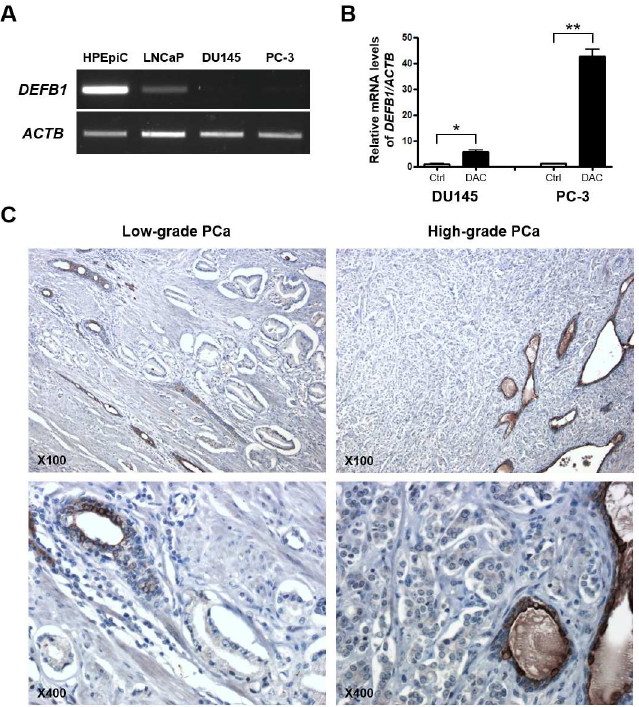
Fig 1. Downregulation of the DEFB1 gene in prostate cancer (PCa) cell lines and tissues. (A) DEFB1 mRNA expressionin prostate epithelial cell lines was assessedby performingRT-PCR. The human ACTB gene (encoding β -actin) was amplifiedas an endogenouscontrol. (B) Quantitative PCR was performed to evaluatethe restorationof DEFB1 mRNA expressionin DU145 and PC-3 cells after treatment with DNA demethylating agent 2 0 -deoxy-5-azacytidine(DAC). * P < 0.05 and ** P < 0.01. (C) Immunohistochemical stainingof DEFB1 in prostate cancer tissue samples. PCa, prostate cancer; NT, non-tumor; T,